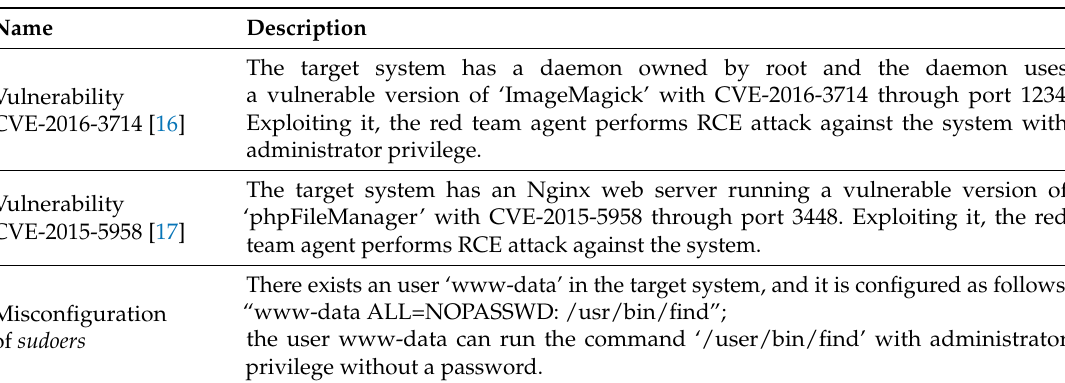
Table 3. Vulnerabilities and misconfiguration for experiments.